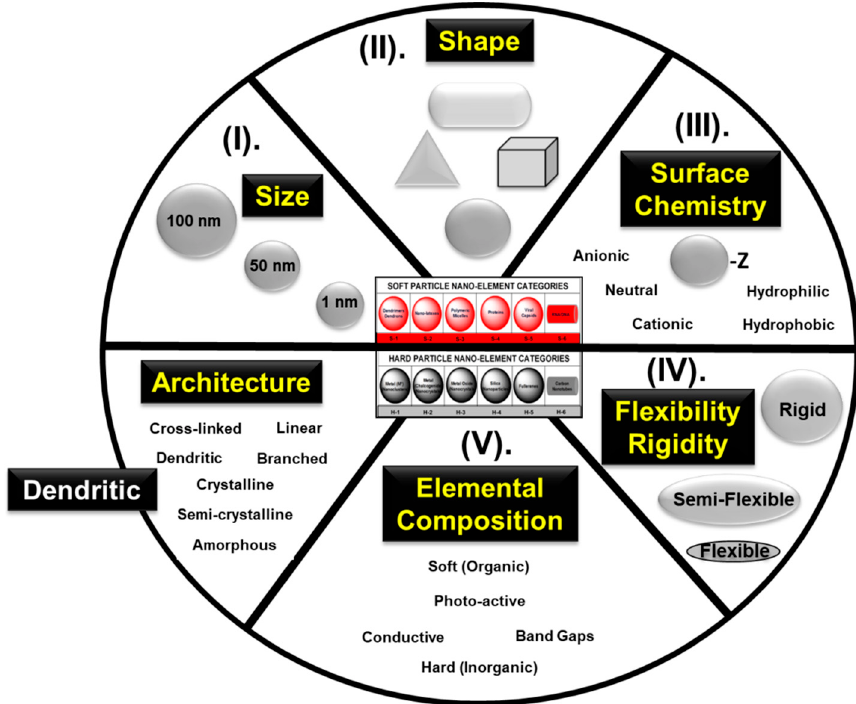
Figure 30. Engineering critical nanoscale design parameters using dendritic architecture, ( I ) size, ( II ) shape, ( III ) surface chemistry, ( IV ) flexibility/rigidity, ( V ) architecture and elemental composition.